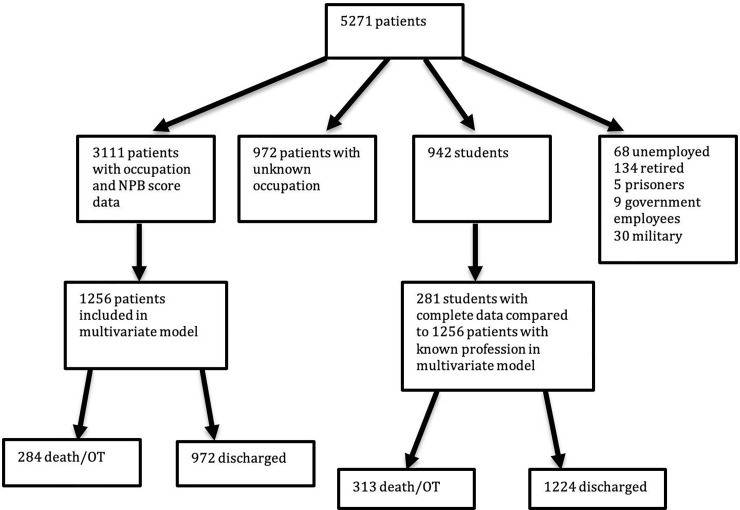
Data flow diagram.